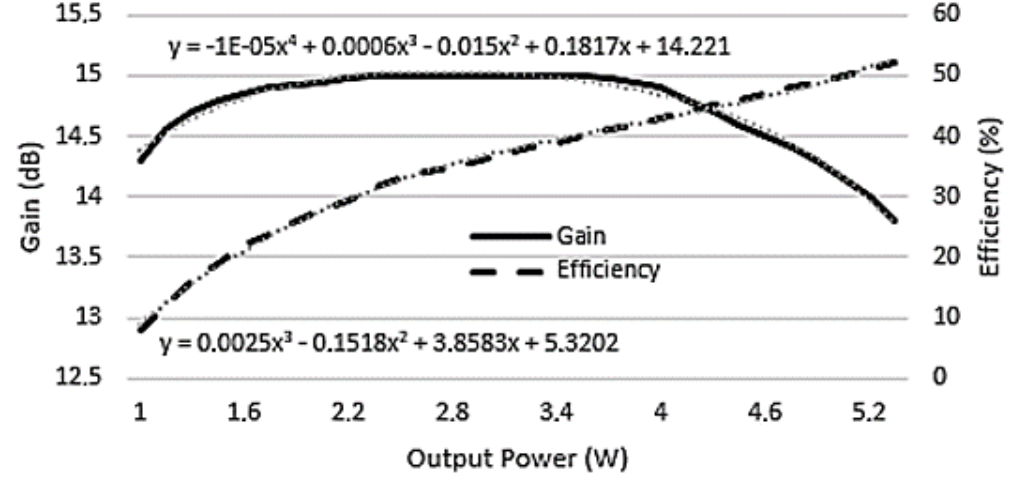
Figure 2. Measured characteristics of a LDMOS power amplifier (PA) (model PD57006S-E, ST Microelectronics) and the polynomial approximations.